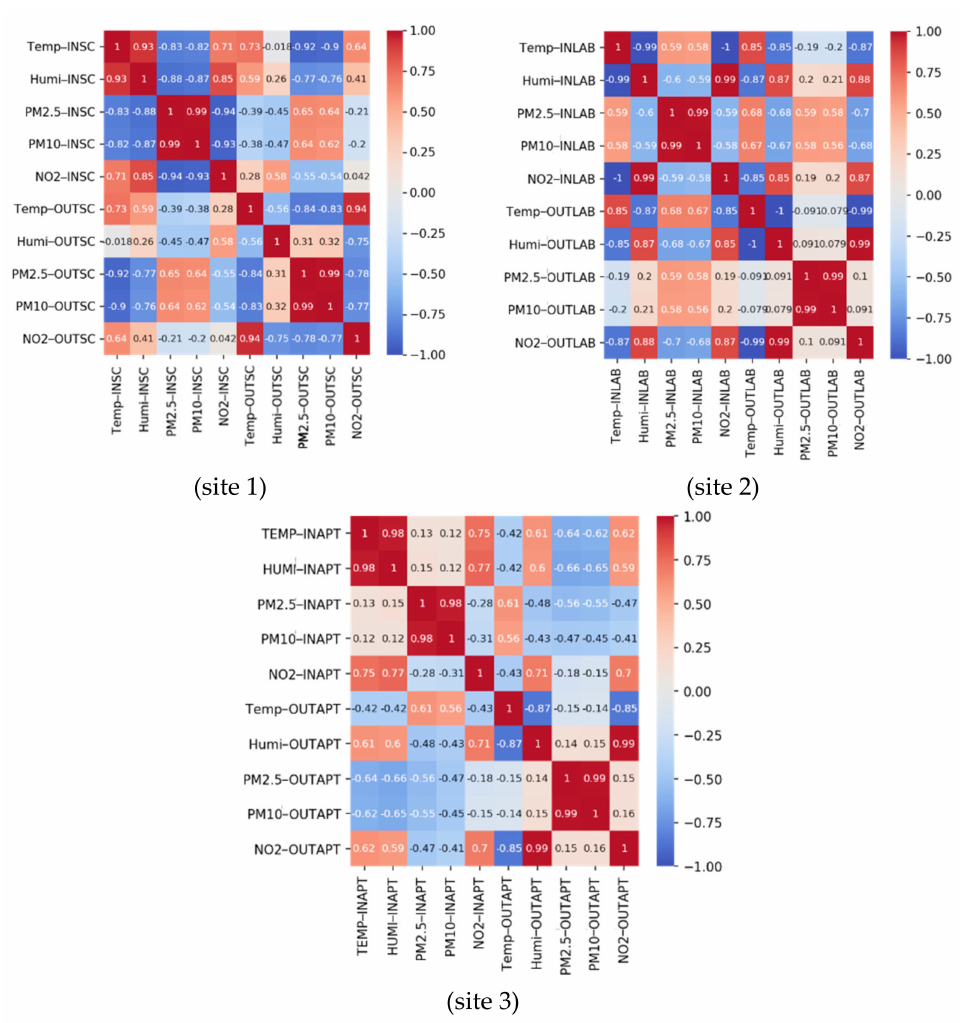
Figure 4. Spearman correlation heat map for indoor and outdoor environmental parameters at three